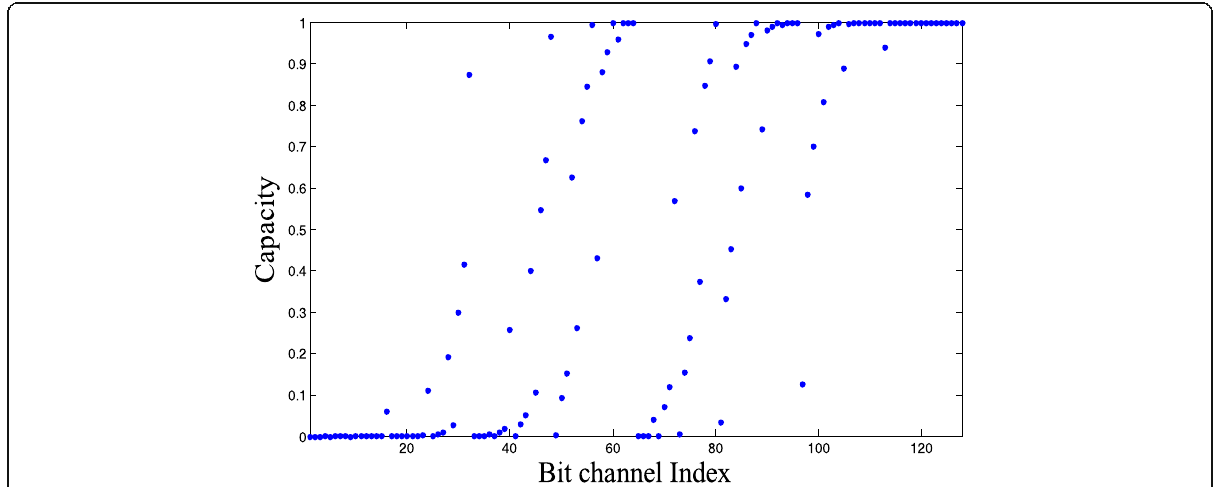
Fig. 3 The capacity of bit channel at N = 128: The capacity of binary erasure channels (BEC) when the code length N is